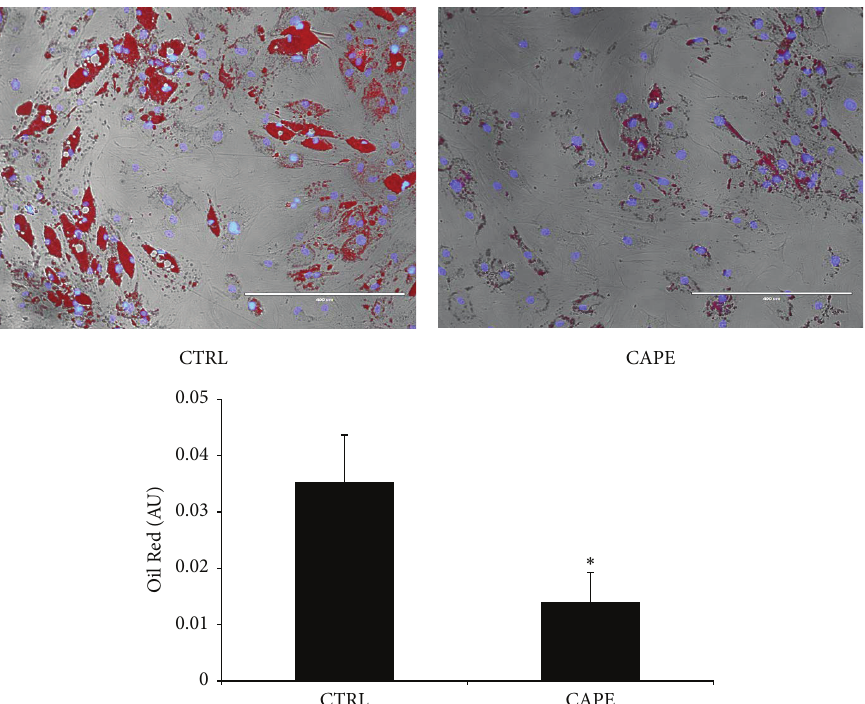
Figure 5: Pictures of lipid droplets of a representative sample in the absence or presence of Cape. Adipogenesis was measured as the relative absorbance of Oil Red O at day 21 after inducing adipogenesis as described in materials and methods (mean ± SD, ∗ 𝑝 < 0.05 versus control). Values represent the means ± SD of 4 experiments performed in triplicate.